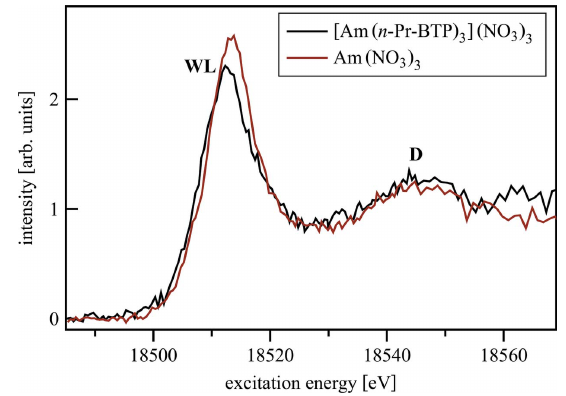
Figure 13 Am L 3 -edge HR-XANES of [Am( n -Pr-BTP) 3 ](NO 3 ) 3 and Am(NO 3 ) 3 .